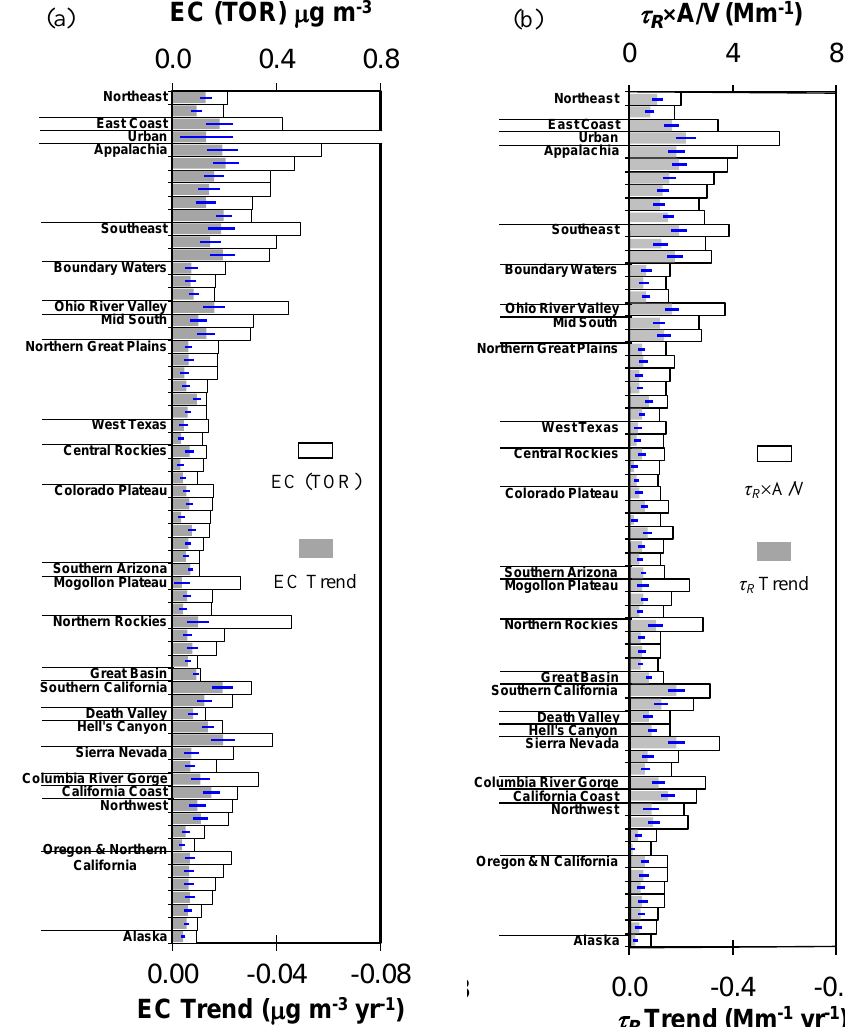
Fig. 7. Median (hollow bar) and trend (solid bar) of: (a) EC by thermal/optical reflectance (TOR) and (b) τ R at 65 IMPROVE sites. See Table 1 for site details. A and V are nominal filter area (3.53cm 2 ) and sample volume (32.7m 3 ) , respectively. Medians are those of 2000– 2004 baseline period. Trends are based on Sen’s slope (2000–2009). The blue bar indicates the 95% confidence interval of the trend.